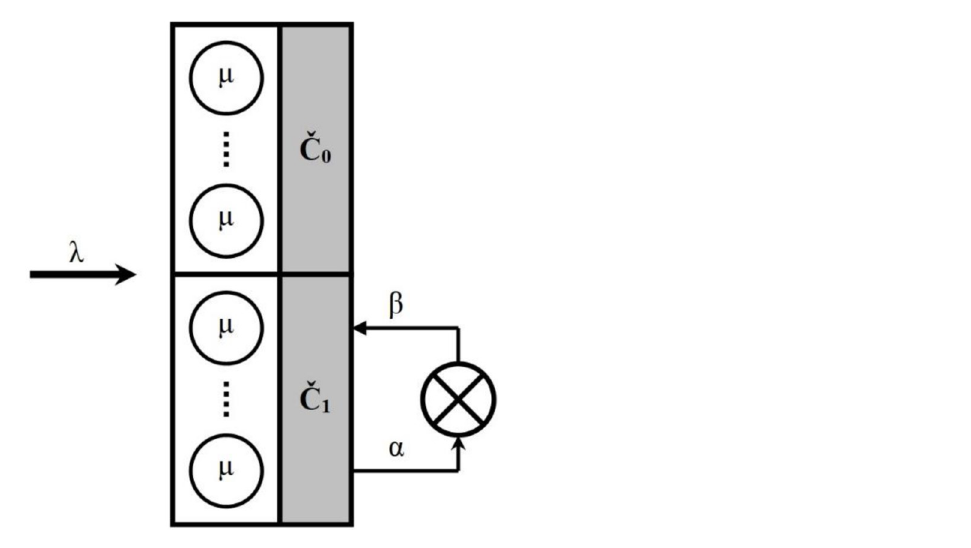
Fig 4. Promising scheme of improving the system presented in Fig